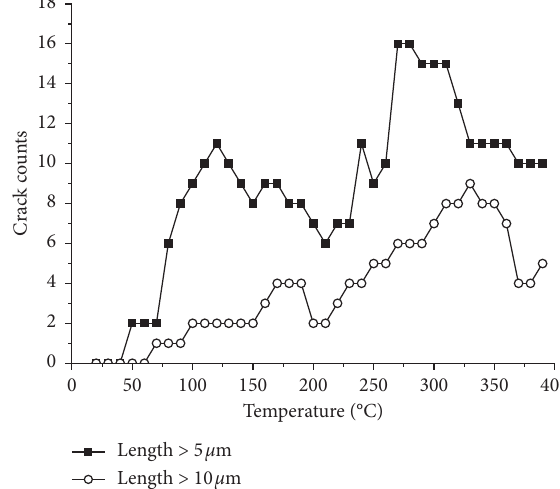
Figure 5: Variation of microcrack counts at elevated temperature [10,